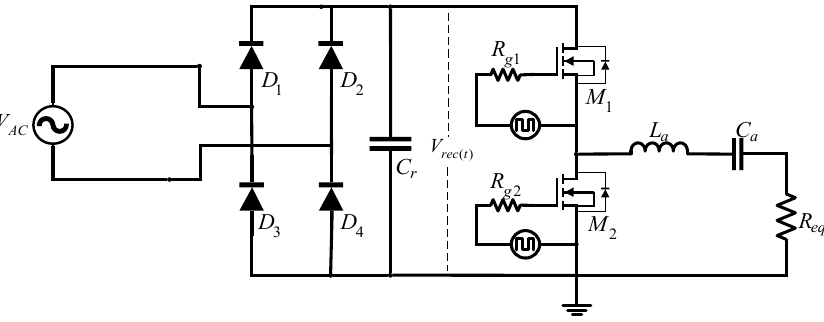
Figure 11. Equivalent circuit of the implemented resonant converter for power factor correction analysis.